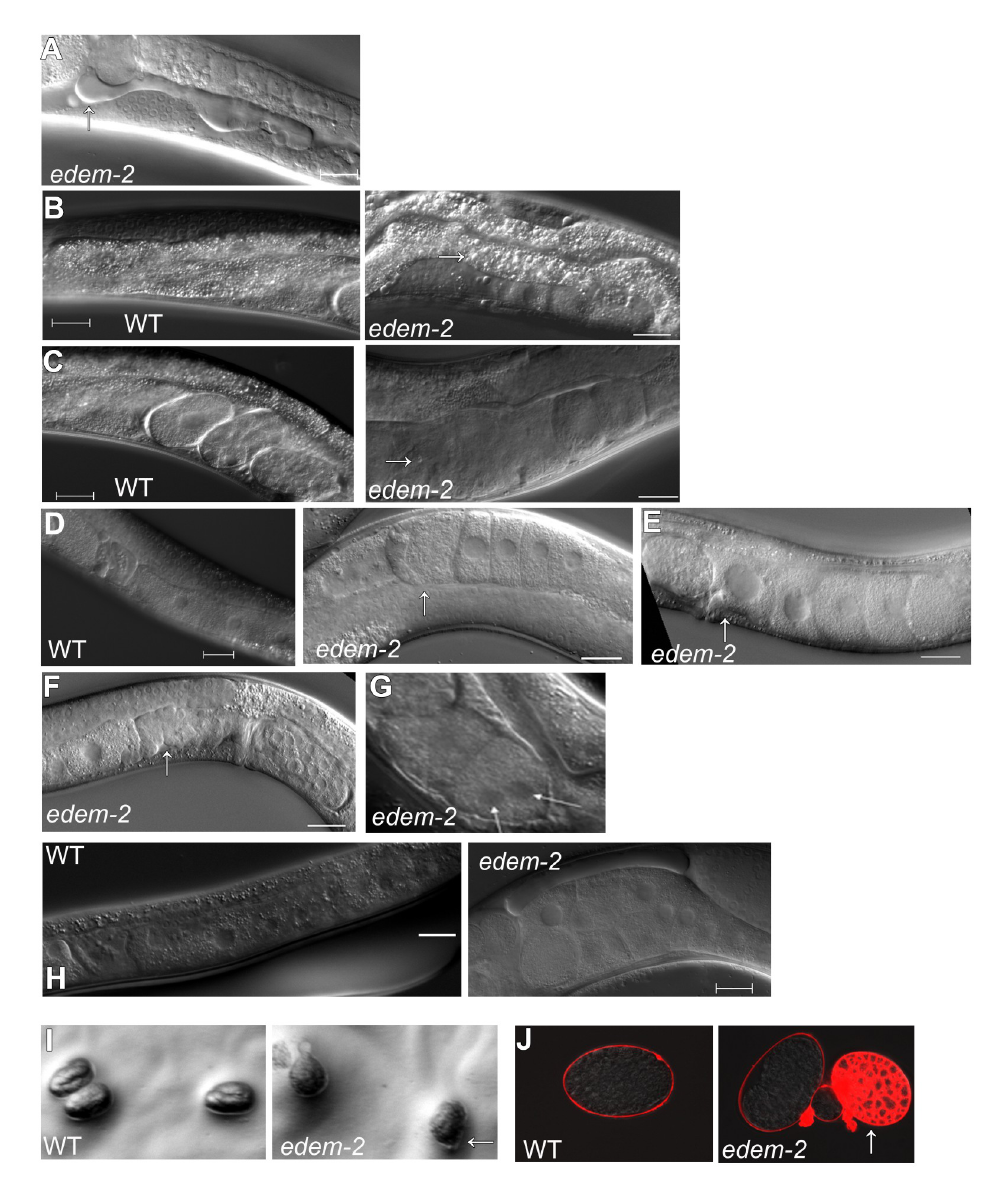
Fig 4. Morphological defects of edem-2 mutants. Representative Nomarski images of edem-2 mutant animals showing: (A) phase liquid accumulation into the body cavity, (B) large vesicles in intestine, (C) torn embryos in the uterus , (D) torn oocytes in the proximal gonad , (E) unfertilized oocytes with a large nucleus in the uterus, (F) undeveloped uterus, (G) cytokinesis defects (2 cells embryo with a binucleated cell), and (H) oocytes accumulation in proximal gonad reflecting defective ovulation. (I) Nomarski images of WT embryos and edem-2 herniated embryos. Arrows indicate the position where chitin is broken, and the cytoplasm of the embryo is extruded. Images were acquired with Zeiss stereo microscope Discovery V20. (J) WT and edem-2 embryos stained with FM4-64 dye. While in WT embryo the chitin formed an effective barrier that blocked dye entrance, the dye penetrated the chitin of edem-2 embryos. Arrow points to an embryo in which the dye penetrated and stained the cell membranes. Scale bar: 20 μ